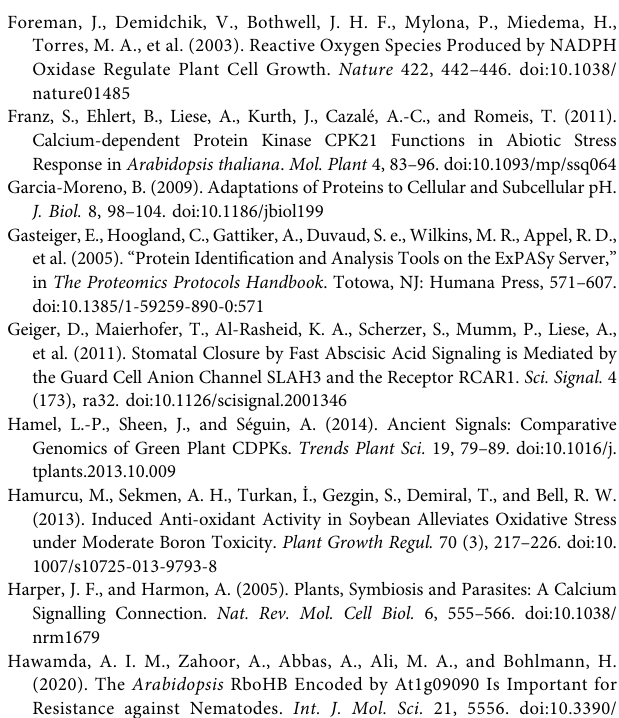
The S. tuberosum chromosome was represented by red solid blocks while A. thaliana, O. sativa , and S. lycopersicum L. were denoted by green, black, and violet colors, respectively. Collinear relationship of CDPKs between S. tuberosum and the other three plants was indicated by red line. Supplementary Figure S2 | Whole genome duplication distribution of S. tuberosum CDPK gene family. Four pairs of duplicated genes were identi fi ed and shown in red